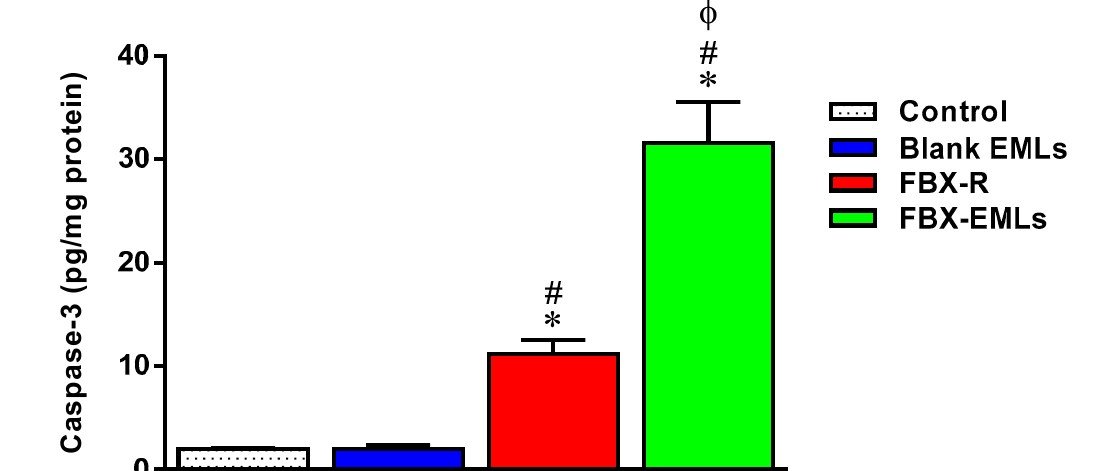
Figure 7. Effect of Blank EMLs, FBX-R, or FBX-EMLs treatments on caspase-3 enzyme contents in HCT 116 cells. Values are expressed as pg/mg of protein. Data are the mean of 4 independent experiments ± SD. * Significantly different vs. Control ( p < 0.05); # Significantly different vs. Blank EMLs ( p < 0.05); Φ Significantly different vs. FBX-R ( p < 0.05).